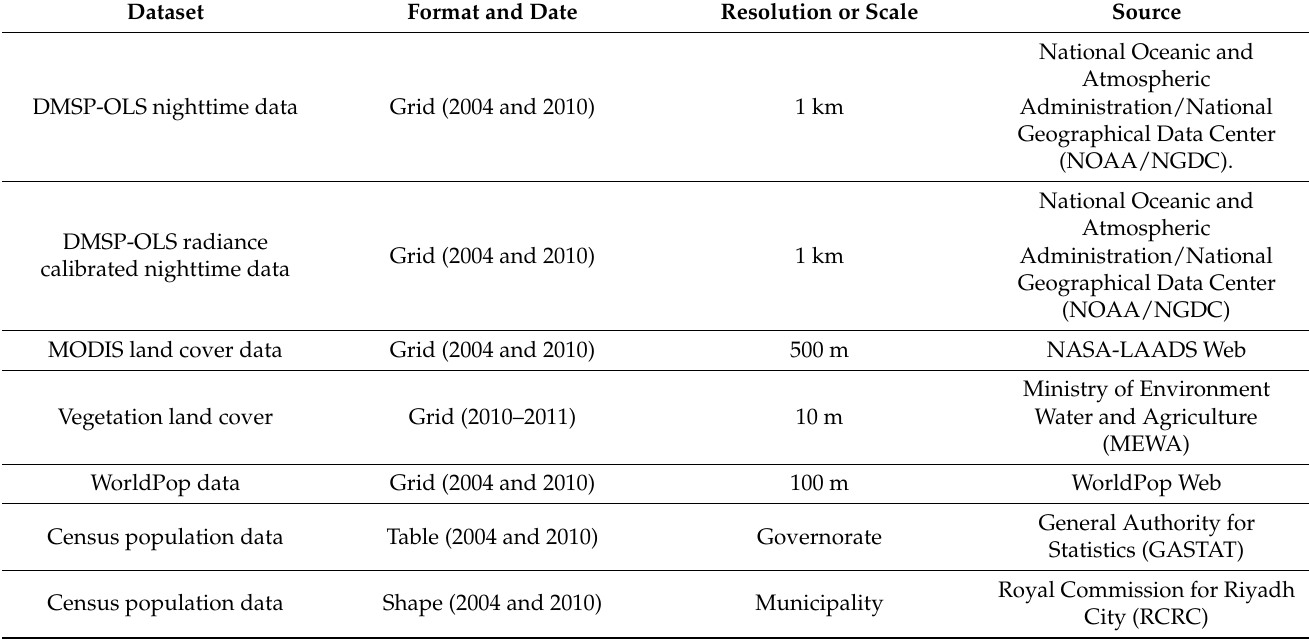
Table 1. Summary of sensor data, statistics, and GIS data used to develop and validate alternative population estimation